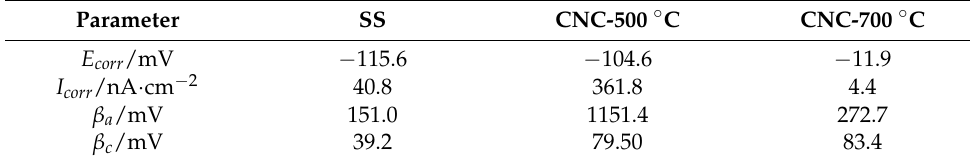
Table 3. Results of linear polarization